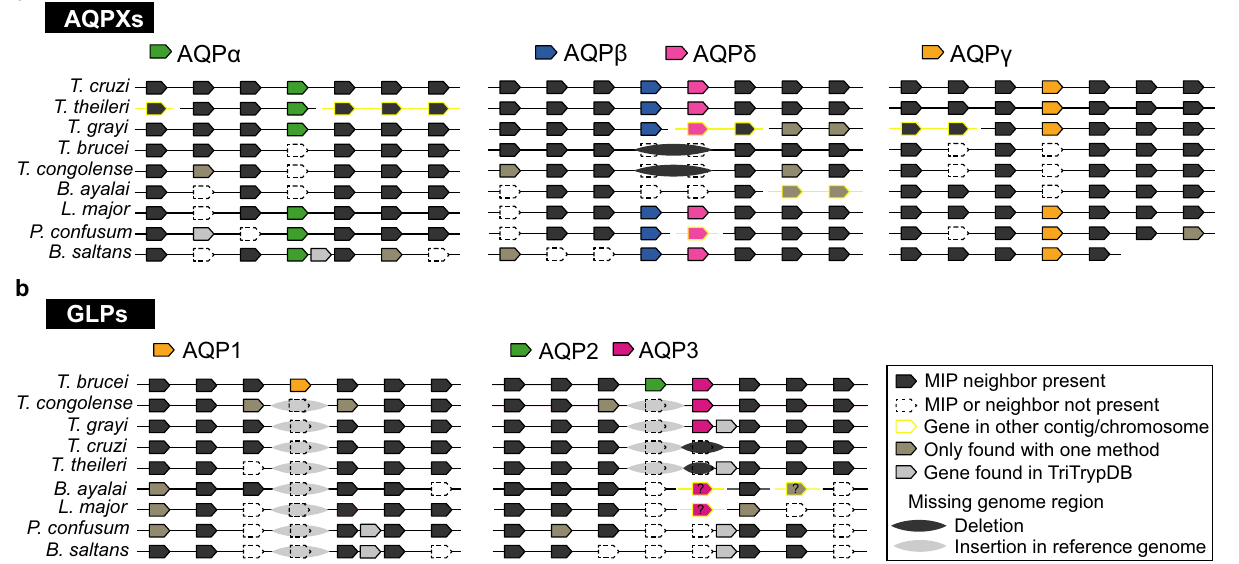
Fig. 5 Synteny analysis of Trypanosomatid MIPs . Comparative gene organization of the regions where a AQPXs and b GLPs are found. The analyzed regions comprise 10 Kb down and up-stream of each MIP in the reference genomes ( T. cruzi or T. brucei ) and the equivalent syntenic regions in the other genomes. For clarity, in this fi gure only the fi rst three genes for down and up-stream regions are shown. Homologous genes are vertically aligned. The graph shows when the syntenic genes are observed using both SimpleSynteny analysis and TritrypDB (black arrow box) or one of these methods (dark gray arrow box). Genes absent in the reference genome ( T. cruzi or T. brucei ) were not detected by SimpleSynteny but were observed in TritrypDB (light gray arrow